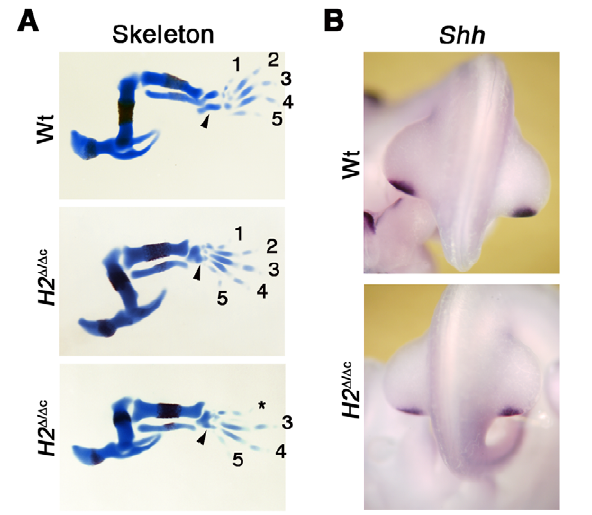
Figure 2. Delayed inactivation of Hand2 in hindlimb buds results in rather normal Shh expression and development. (A) Hindlimb buds skeletons at E14.5, stained with alcian blue (cartilage) and alizarin red (bone). Prx1 -Cre mediated inactivation of Hand2 ( H2 D / D c ) in hindlimb buds results in all cases in fusion of the tarsals (arrowheads) and formation of 5 (n=11/24) or 4 (n=13/24) digits. Please note that in latter case the formation of digit 2 and/or 3 (not shown), which depend mostly on long-range SHH signaling [7] is always affected. (B) Shh expression in wild-type and Hand2 deficient hindlimb buds at E10.75 (37 somites). Note that the expression domain is correctly positioned in H2 D / D c hindlimb buds, but expression levels are